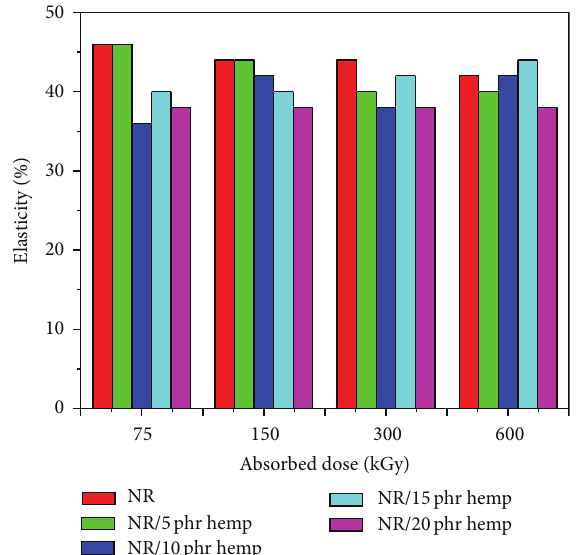
Figure 2: Elasticity variation as a function of hemp amount and irradiation dose.